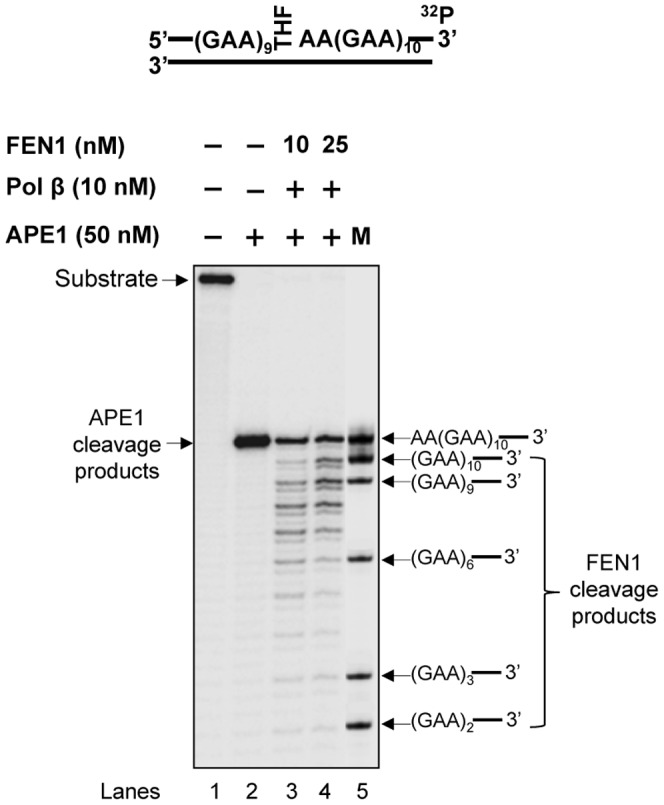
FEN1 cleavage during BER of an abasic lesion in the context of (GAA)20 repeats.FEN1 cleavage activity during repair of an abasic lesion in the context of GAA repeats was determined by incubating the (GAA)20-THF substrate with 10 nM and 25 nM FEN1 under the conditions described in the Materials and Methods. Lane 1 corresponds to the substrate only. Lane 2 corresponds to reaction mixtures with 50 nM APE1. Lanes 3−4 correspond to reaction mixtures with 10 nM and 25 nM FEN1 in the presence of 10 nM pol β. Lane 5 corresponds to synthesized size markers (M). The substrate was 32P-labeled at the 3'-end of the damaged strand and illustrated schematically above the gel.